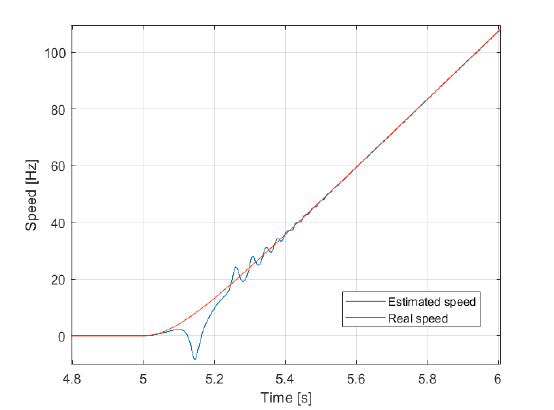
Figure 9. V-I observer not estimating at